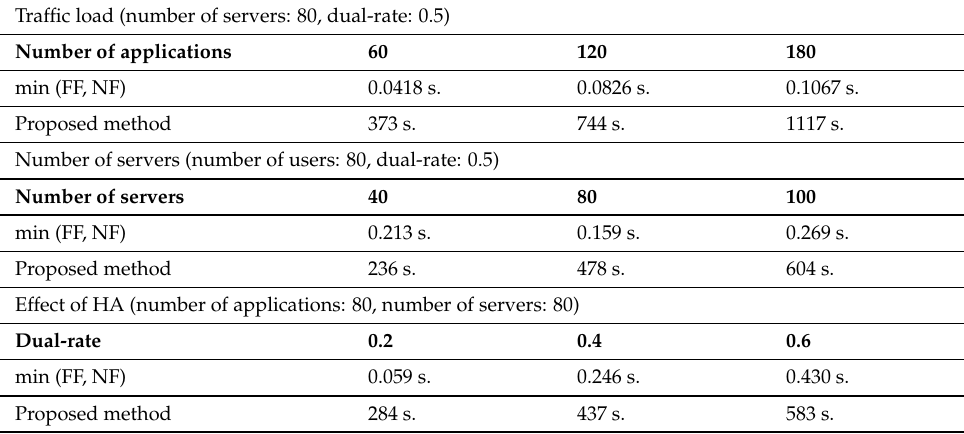
Table 11. Execution time in the